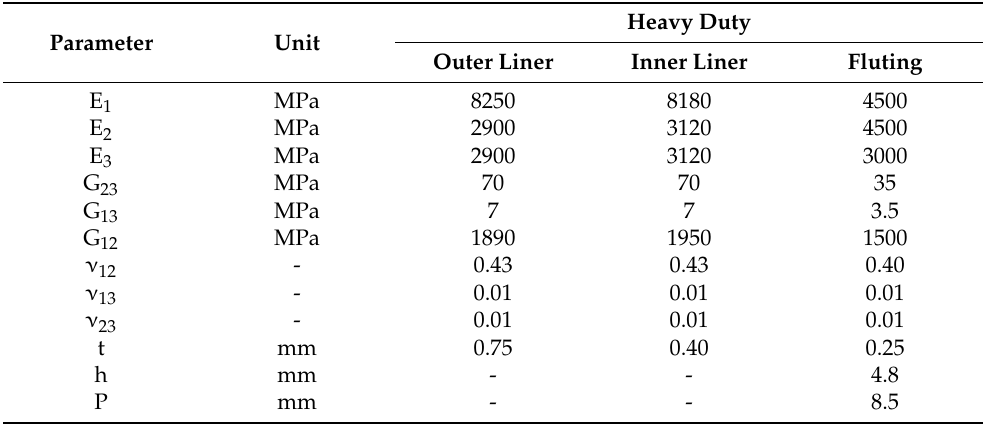
Table 2. Material properties: elastic moduli, E i , shear moduli, G ij , and Poisson ratios, ν ij . Reprinted with permission from ref. [12]. Copyright 2021